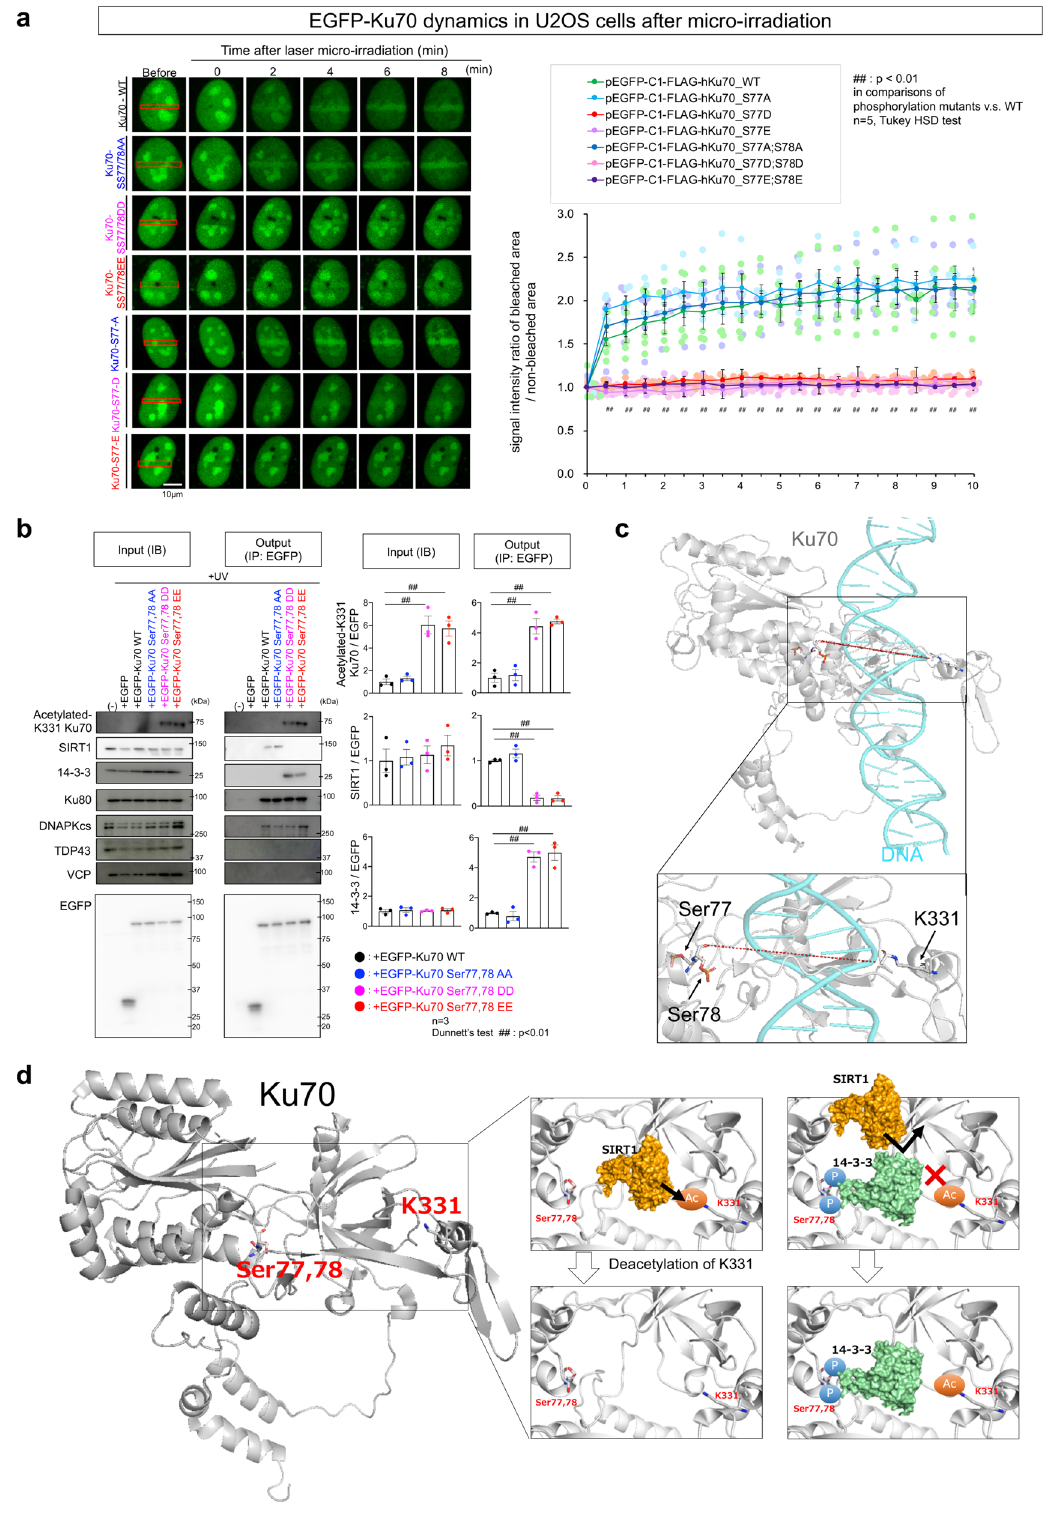
Fig. 2 Ku70 phosphorylation at Ser77/78 impairs Ku70 foci formation after DNA damage and prevents deacetylation by SIRT1. a Ku70 phosphorylation at Ser77/78 impairs dynamics to DNA damage foci. Upper panels show accumulation of wild-type, non-phospho-mimetic mutant, and phospho-mimetic mutants of Ser77/78 or Ser77 to DNA damage foci in U2OS cells after microirradiation. Values in each group are summarized by mean ± SEM. b Co-immunoprecipitation of phospho-mimetics of Ku70 reveals a physical interaction between Ku70 and either SIRT1 or 14-3-3. Phosphorylation of Ku70 results in a change of acetylation state. The phosphorylation state of Ku70 does not affect interactions with Ku80 or DNA PKcs. Ku70 does not interact with TDP43 or VCP. Right graphs show quantitative analyses of three independent experiments ( n = 3, ## p < 0.01 in Dunnett ’ s test). c Positional relationship between Ser77/78 and Lys331 in the Ku70 structure when bound to DNA (PDB: 1JEY). d Hypothetical model depicting the competitive interactions of SIRT1 and 14-3-3 with Ku70 and the resultant acetylation of Lys331. COMMUNICATIONS BIOLOGY| (2021) 4:1175